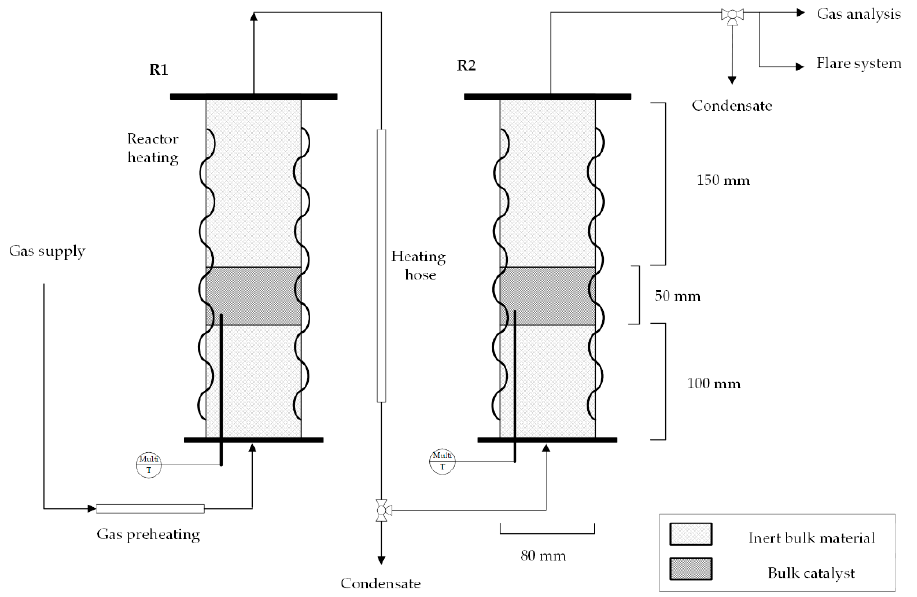
Figure 3. Laboratory double-stage methanation set-up consisting of two fixed-bed reactors (R1 and R2) with an introduced multi-thermocouple in the catalyst bed. Table 3. Steam gasification syngas composition used for experimental lab-scale methanation test runs at 7 bar and at GHSV = 2000 h − 1 . Hydrogen included in the syngas and additional supplied hydrogen are